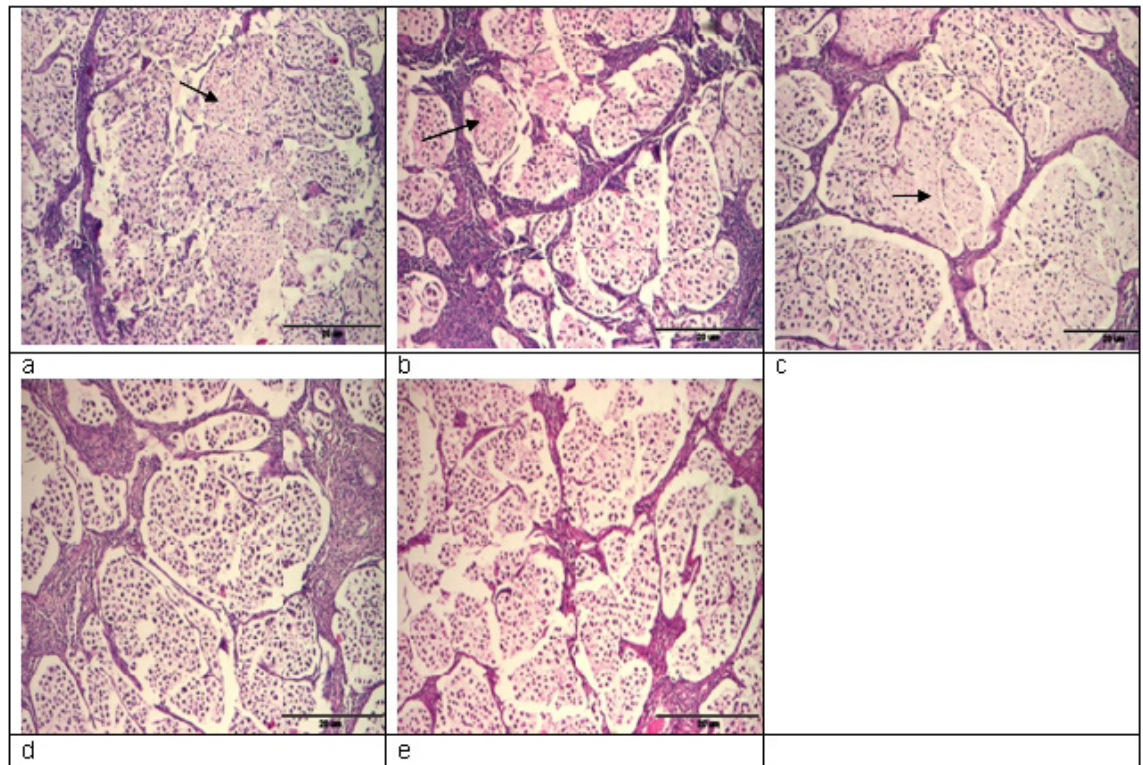
Figure 4 . Histological aspect of tumors stained with hematoxylin and eosin. The effect of photodynamic therapy (PDT) was deter- mined by evaluating the percentage of necrotic cells within the total number of cells under 400X magnification in a microscopic field of 10 randomly selected areas in each tumor sample (scale bar = 20 μm). At 24 h after PDT, amorphous cells with pyknotic or absent nuclei were observed, without clear intercellular limits. The magnification of the histological images was 40X. a , ZnTMPP+IR; b , TMPP+IR; c , 5-ALA+IR; d , control group; e , IR group. TMPP = 5,10,15,20-tetrakis(4-methoxyphenyl)-porphyrin; ZnTMPP = TMPP zinc compound; 5-ALA = 5-aminolevulinic acid; IR = irradiation.